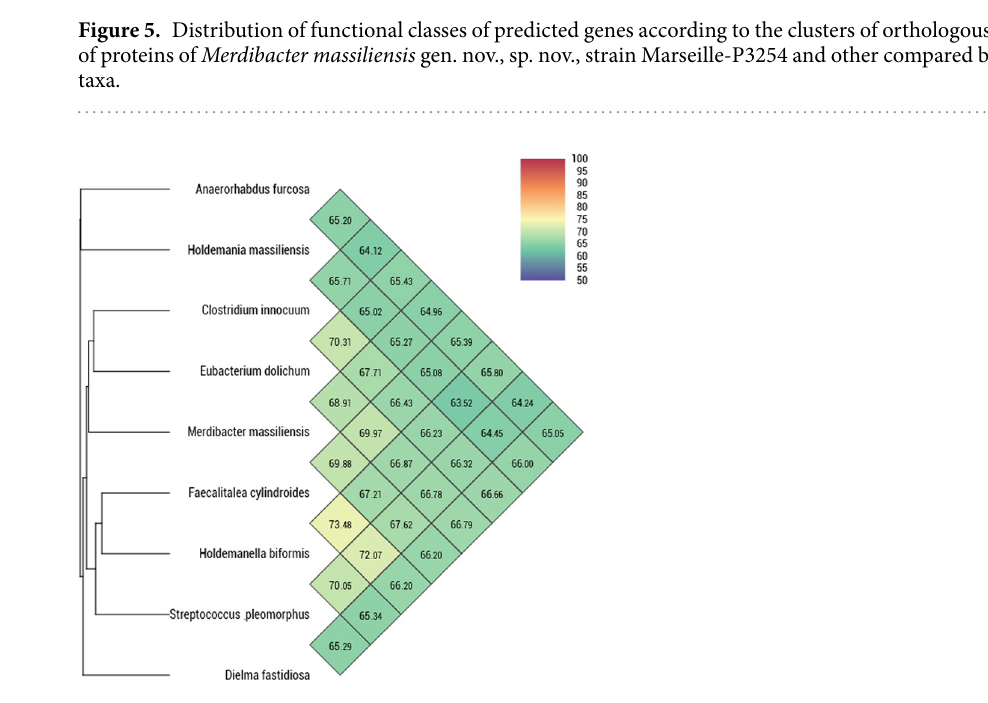
Figure 6. Heatmap generated with OrthoANI values calculated using the OAT software between Merdibacter massiliensis gen. nov., sp. nov., strain Marseille-P3254 and other closely related taxa with standing in